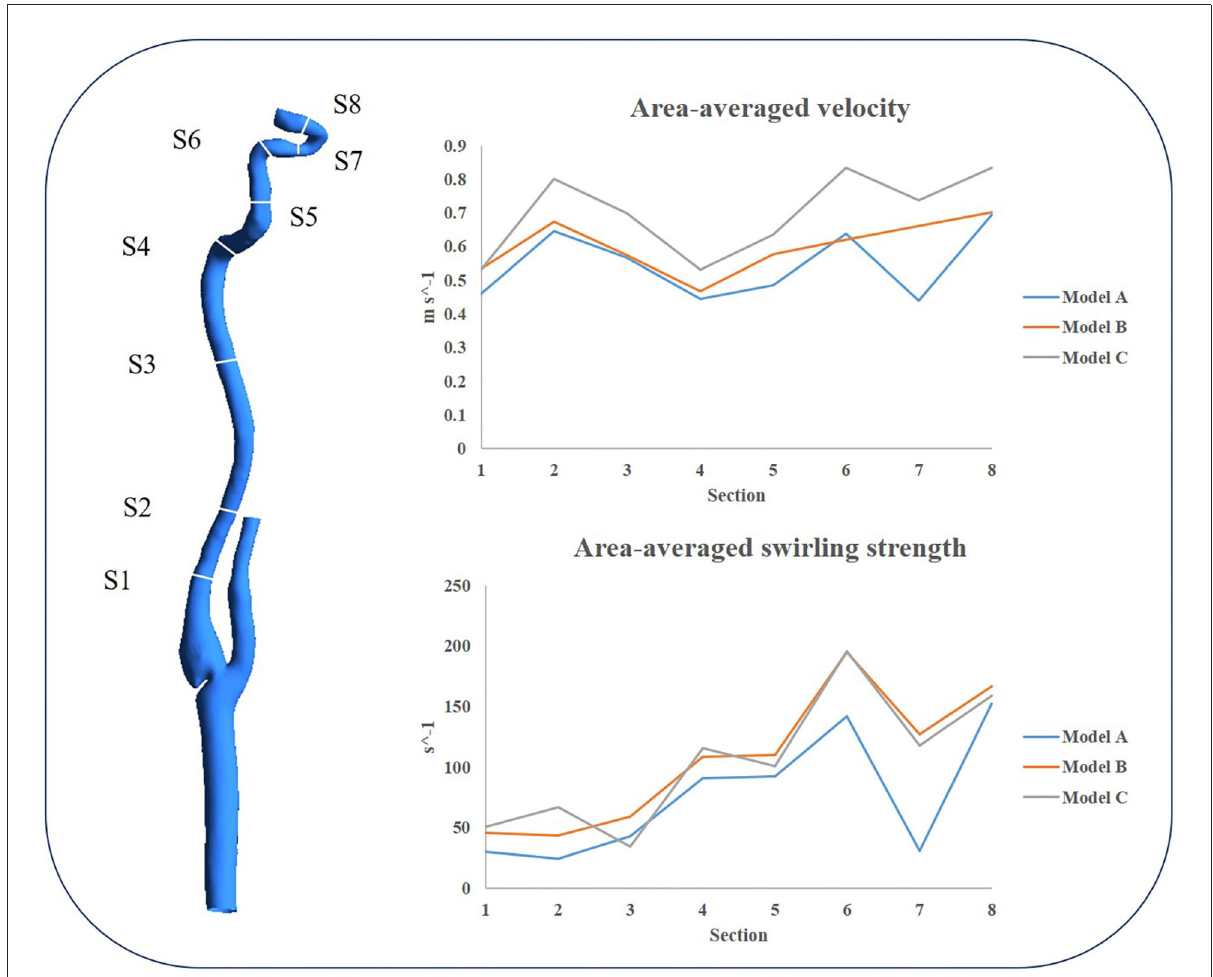
FIGURE9 The cross sections are shown on the left; area-averaged velocity and area-averaged swirling strength in eight cross sections are shown on the right at the peak